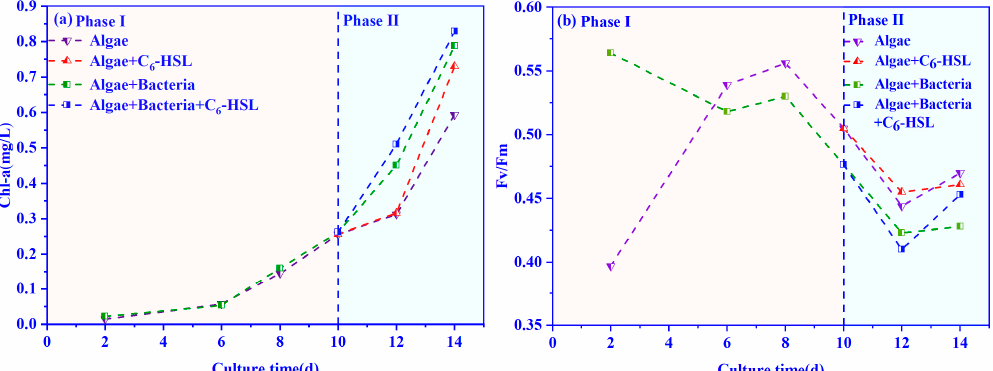
Figure 4. Effect of 10ng/L C 6 -HSL on ( a ) Chl-a and ( b ) Fv/Fm of algae group and algae–bacteria group. Algal+C 6 -HSL and algae+bacteria+C 6 -HSL are algae group and algae–bacteria group treated with C 6 -HSL, respectively. Phase I is without the addition of C 6 -HSL, and Phase II is with the addition of C 6 -HSL.